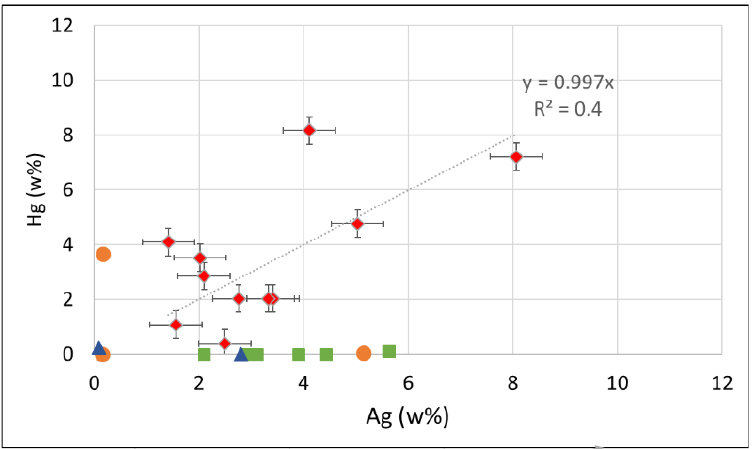
Figure 4. Silver vs. mercury contents (in wt%) for the counterfeit coins of the Preuschdorf hoard coming from the cities of Strasbourg (blue) and St. Gallen (green), the county of Pfalz-Veldenz (red), and the bishopric of Chur (orange).